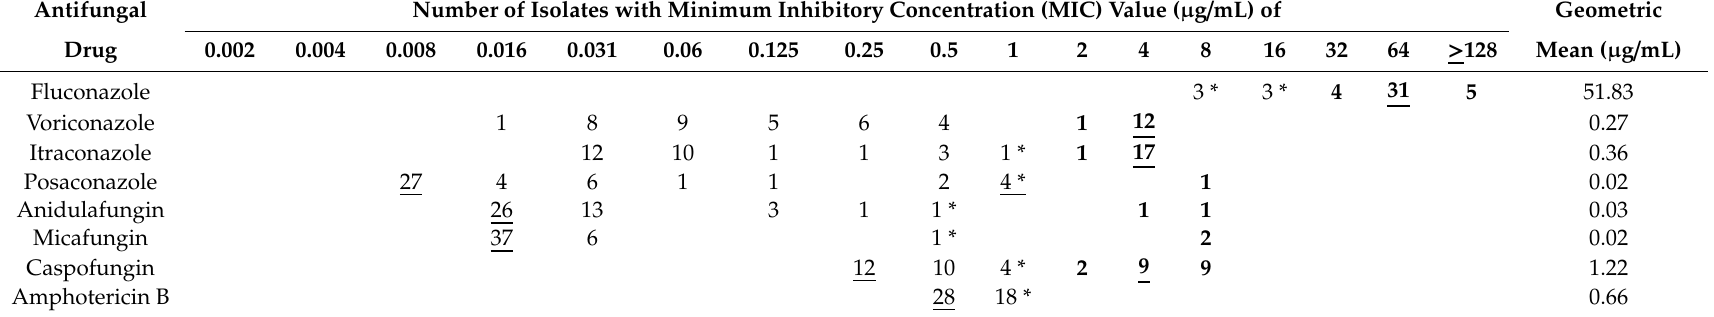
Table 3. In vitro antifungal susceptibility testing results of C. auris isolates ( n = 46) from colonized patients against fluconazole, voriconazole, itraconazole, posaconazole, anidulafungin, micafungin, caspofungin and amphotericin B after 24 h of incubation at 35 ◦